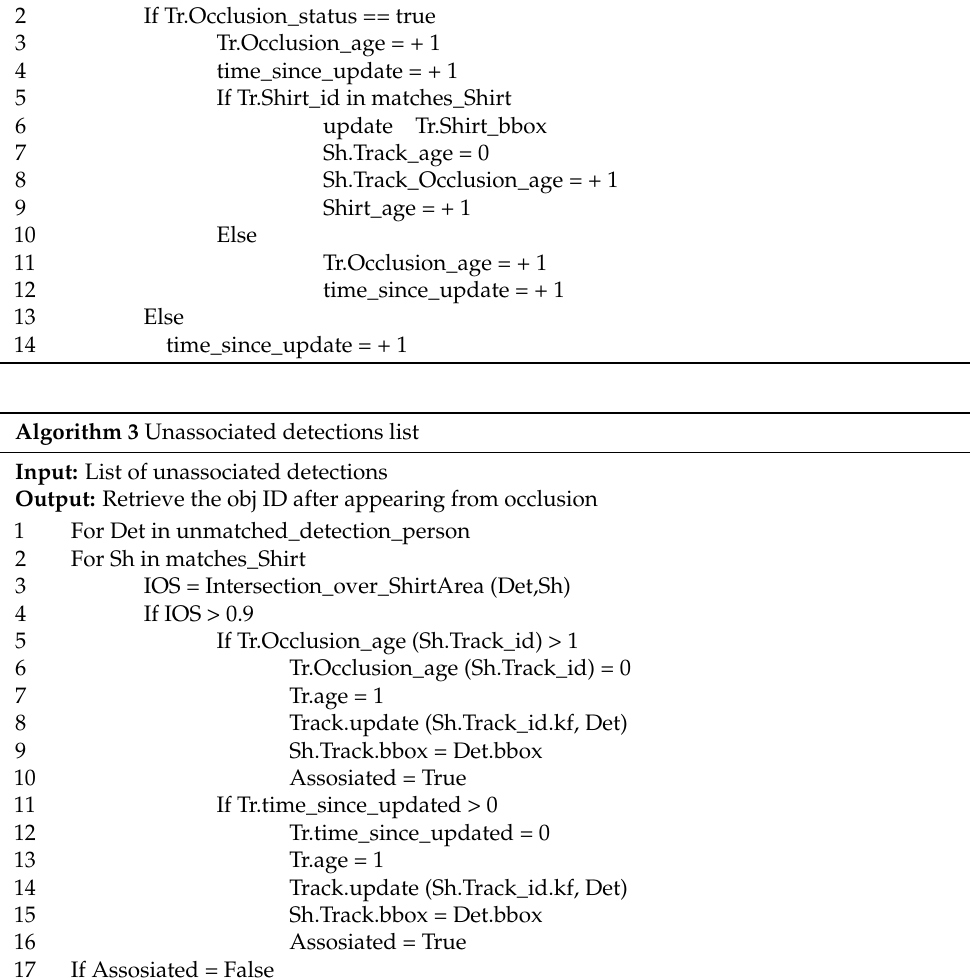
Algorithm 2 Unassociated tracks list